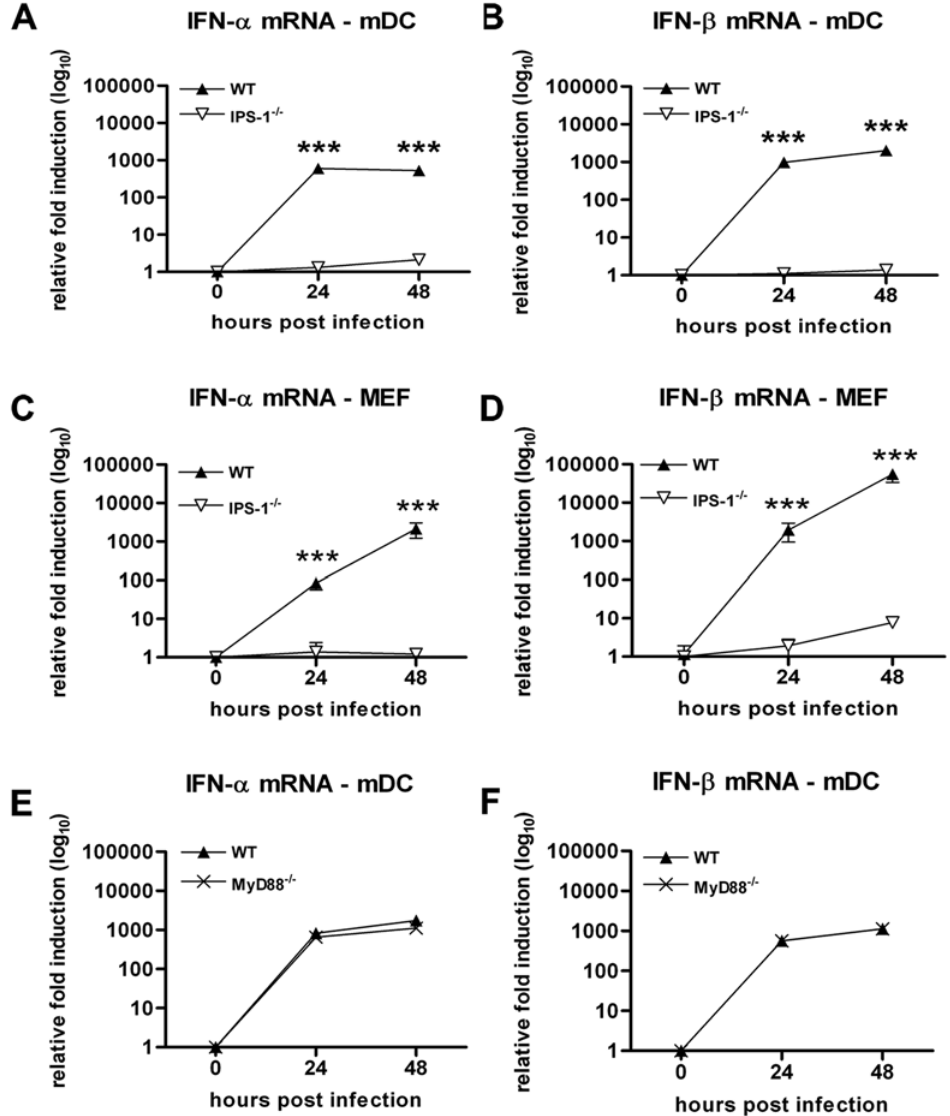
Figure 10. The IFN- b response in mDC and MEF is IPS-1-dependent but MyD88-independent. mDC and MEF generated from wild type, IPS-1 2 / 2 and MyD88 2 / 2 , mice were infected at an MOI of 0.1 and levels of ( A , C , and E ) IFN- a and ( B , D , and F ) IFN- b mRNA were quantified by qRT- PCR. Values are an average of duplicate samples generated from three independent experiments. Asterisks indicate values that are statistically significant (***, P ,